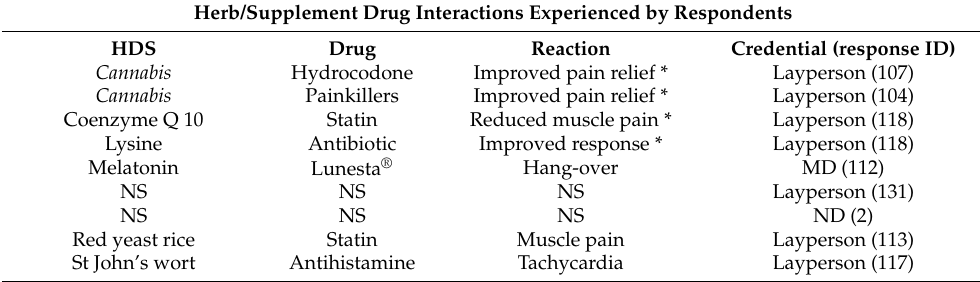
Table 1. Herb/Supplement Drug Interactions (HDI) reported in